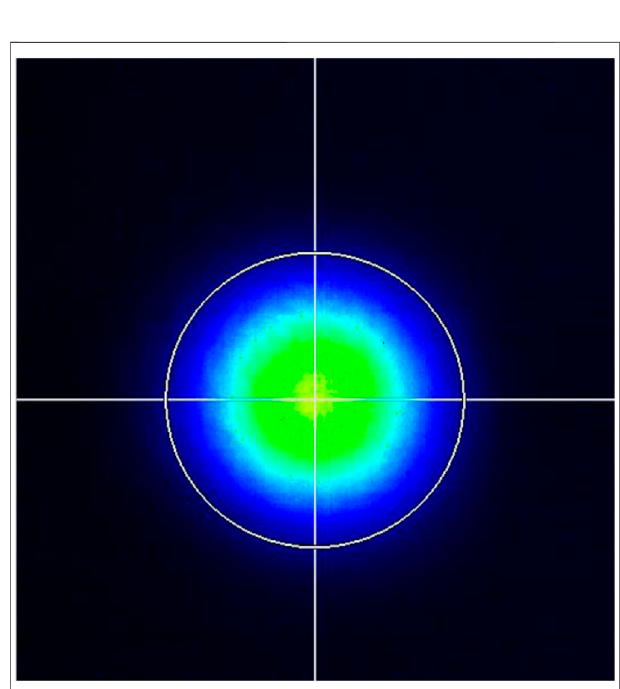
FIGURE 10 | Typical beam of the regenerative ampli fi